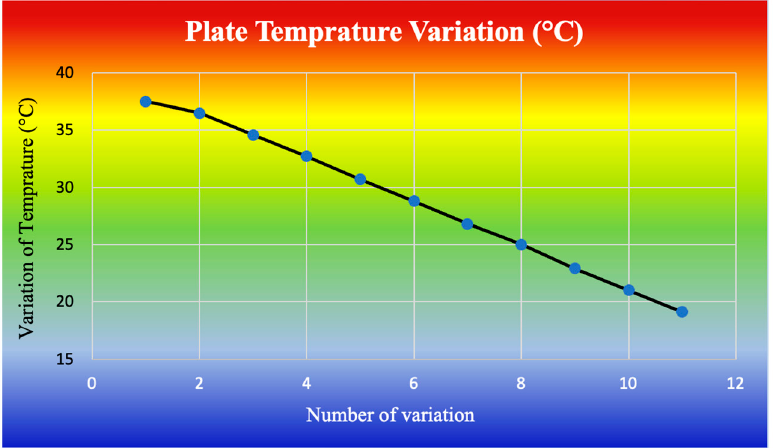
Figure 14. Temperature variation of the structure.